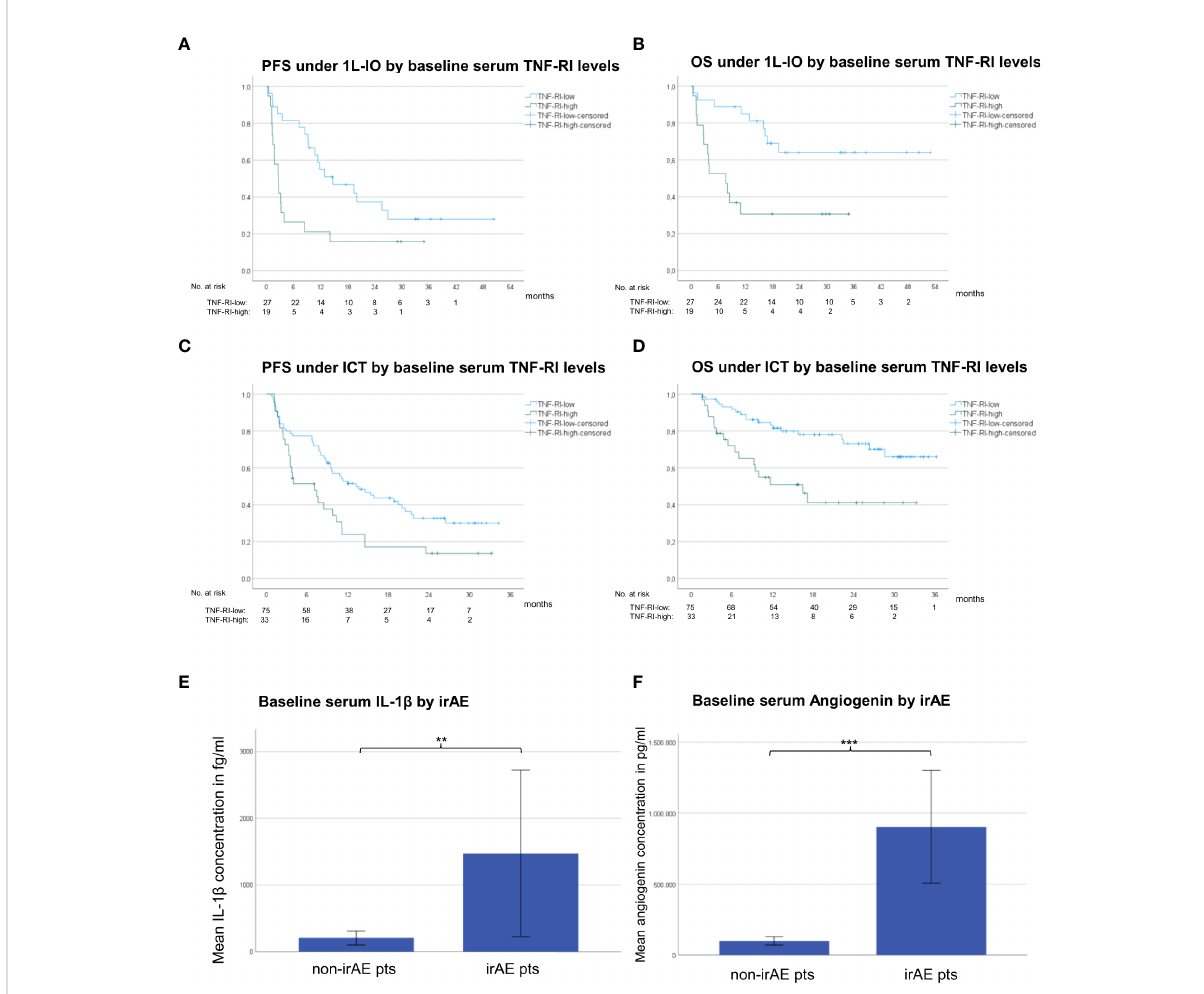
FIGURE 4 Serum cytokines associated with immunotherapy ef fi cacy and toxicity in NSCLC. (A) The median progression-free survival (PFS) under PD-(L)1 monotherapy for patients with low TNF-RI at diagnosis (<2139.7 pg/ml, please see Supplementary Figure 1) was 442 days vs. 80 days for patients with high TNF-RI. (B) The median overall survival (OS) under PD-(L)1 monotherapy for patients with low TNF-RI at diagnosis (<2139.7 pg/ml) was not reached vs. 229 days for patients with high TNF-RI. (C) The median PFS under immunochemotherapy (ICT) for patients with low TNF-RI at diagnosis (<2139.73 pg/ml, please see Supplementary Figure 1) was 409 days vs. 212 days for patients with high TNF-RI. (D) The median OS under ICT for patients with low TNF-RI at diagnosis (<2139.73 pg/ml) was not reached vs. 493 days for patients with high TNF-RI. (E) The